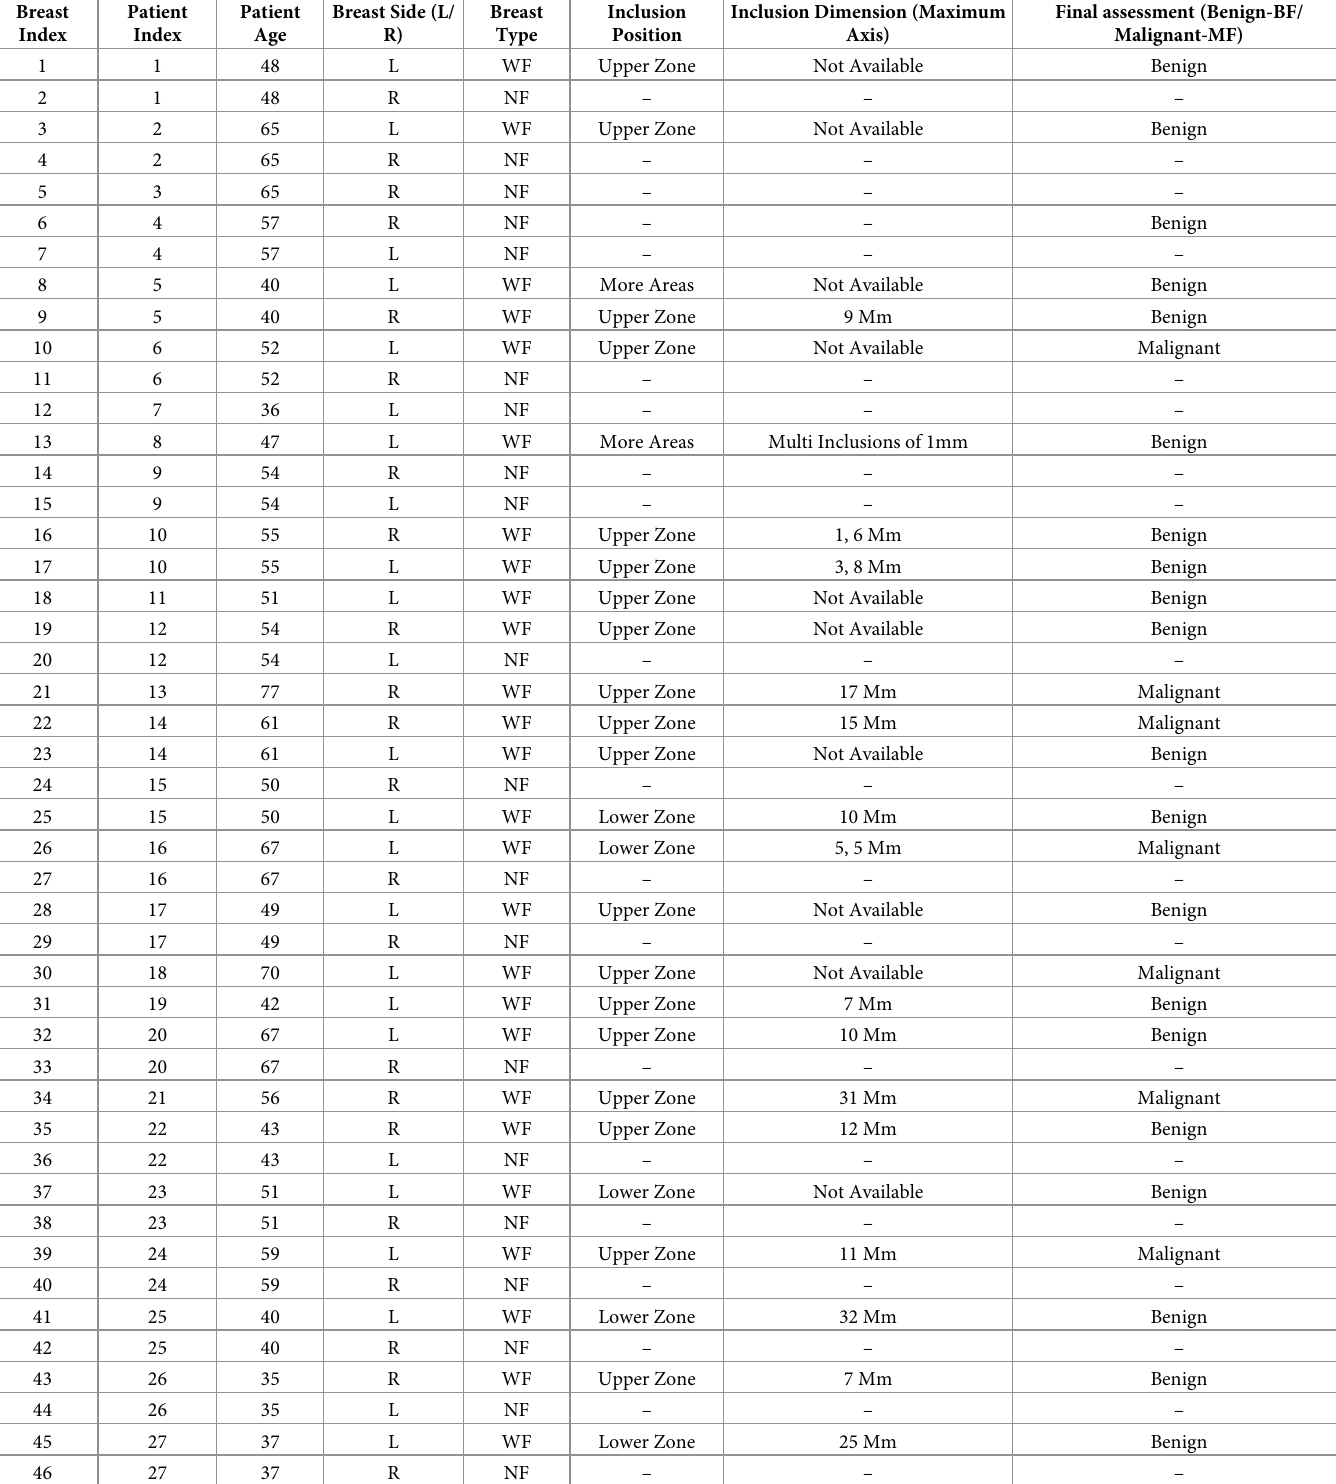
Table 2. Breast index, patient index, age, examined breast (L /R), breast category (NF, BF, and MF) from the radiologist (gold standard information), lesion posi- tion, and dimensions are all listed here. Breast